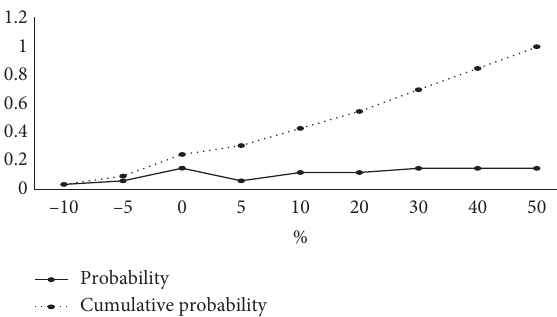
Figure 3: Probability distribution and cumulative probability of value nodes.